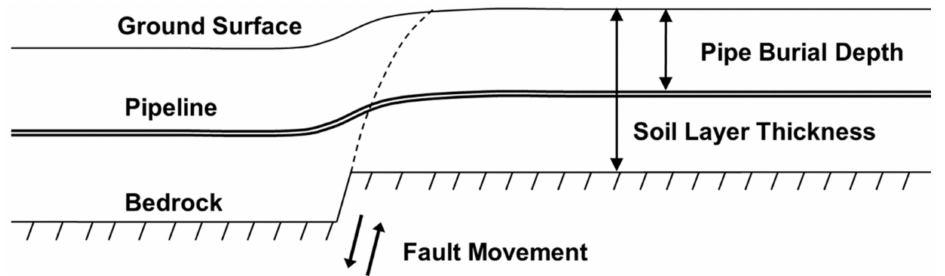
Figure 2. Pipeline buried inside a soil layer, subjected to fault